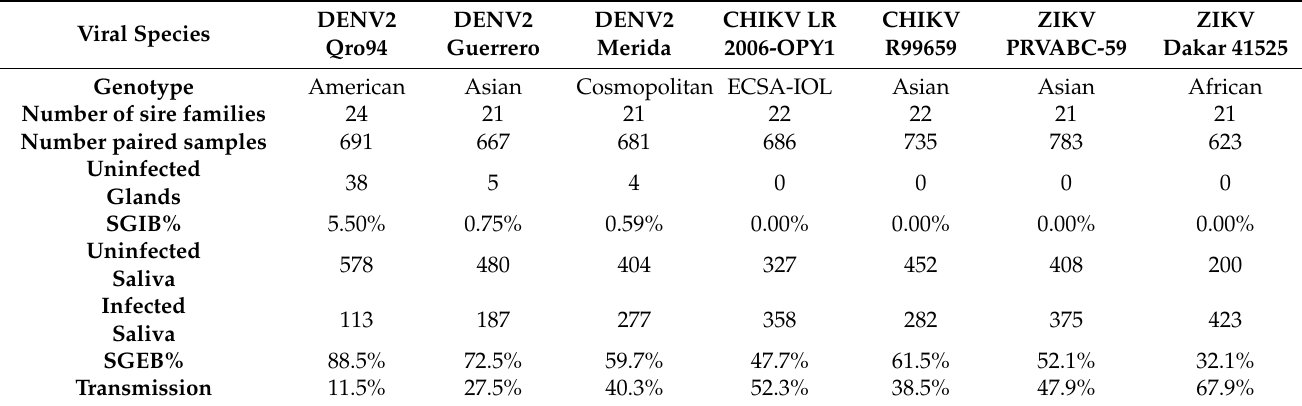
Table 1. Infection rates for salivary gland infection barrier (SGIB) and salivary gland escape barrier (SGEB) for each of the seven viral